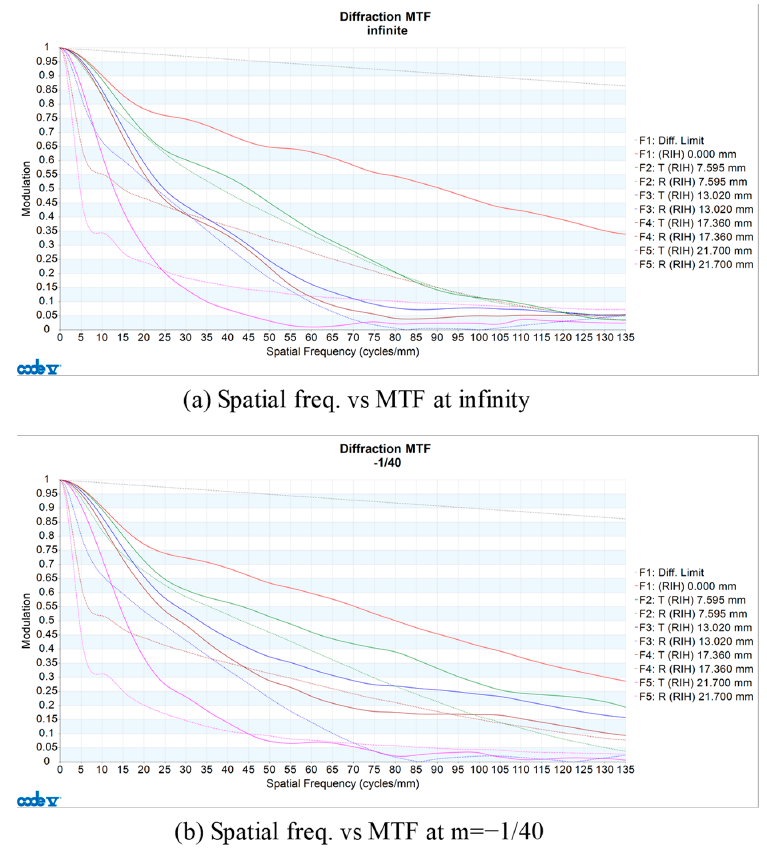
Figure 12. Frequency vs. MTF plots of the final designs at the infinite and main imaging distance.